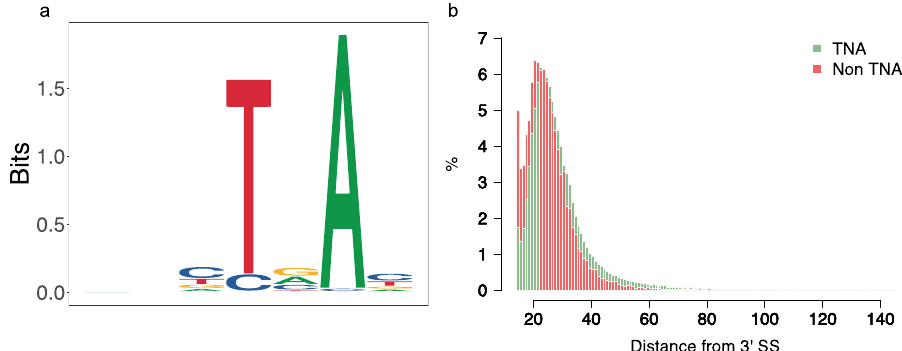
Fig. 3 Characteristics of the branch point sequence in bovine introns. Sequence logo plot generated from 179,476 branch point sequences identi fi ed in the bovine genome ( a ). Distribution of the distance between the predicted branch point and the 3 ’ splice site for canonical (TNA) (green) and noncanonical (non-TNA) (red) branch point sequences ( b ).